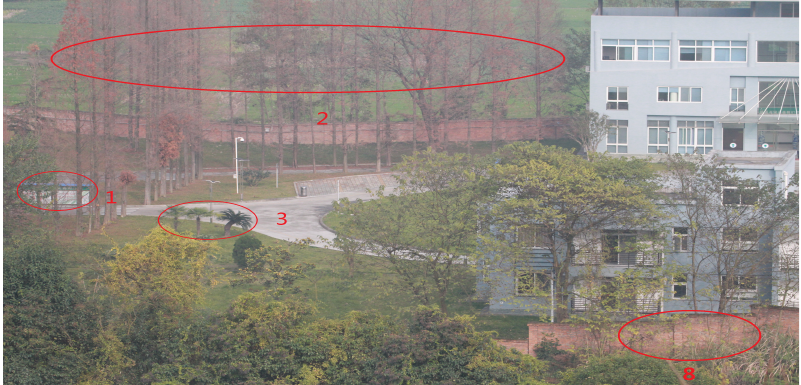
Figure 6. Close optical image of targets 1–3, with the billboard and trees.